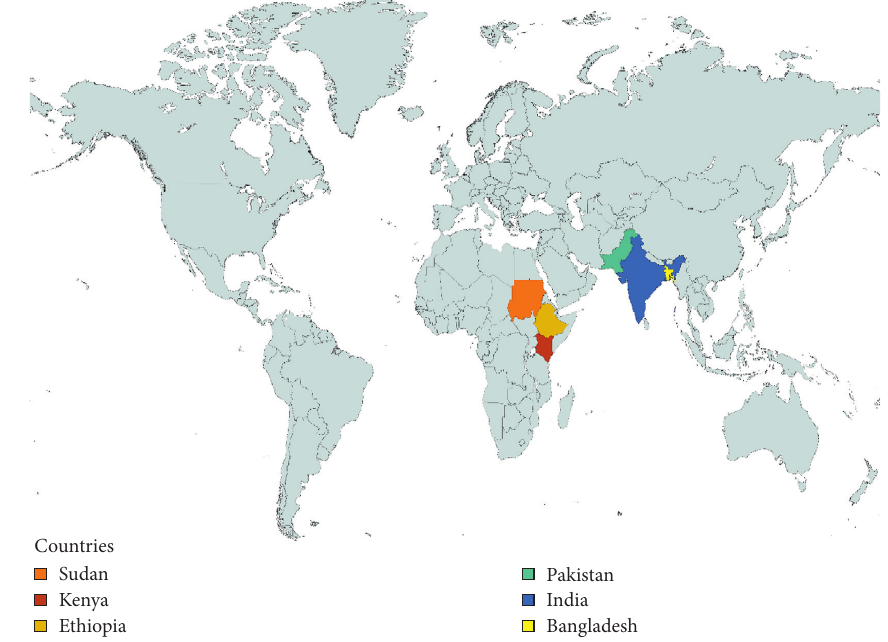
Figure 3: Countries included in the study. Table 1: Characteristics of the included